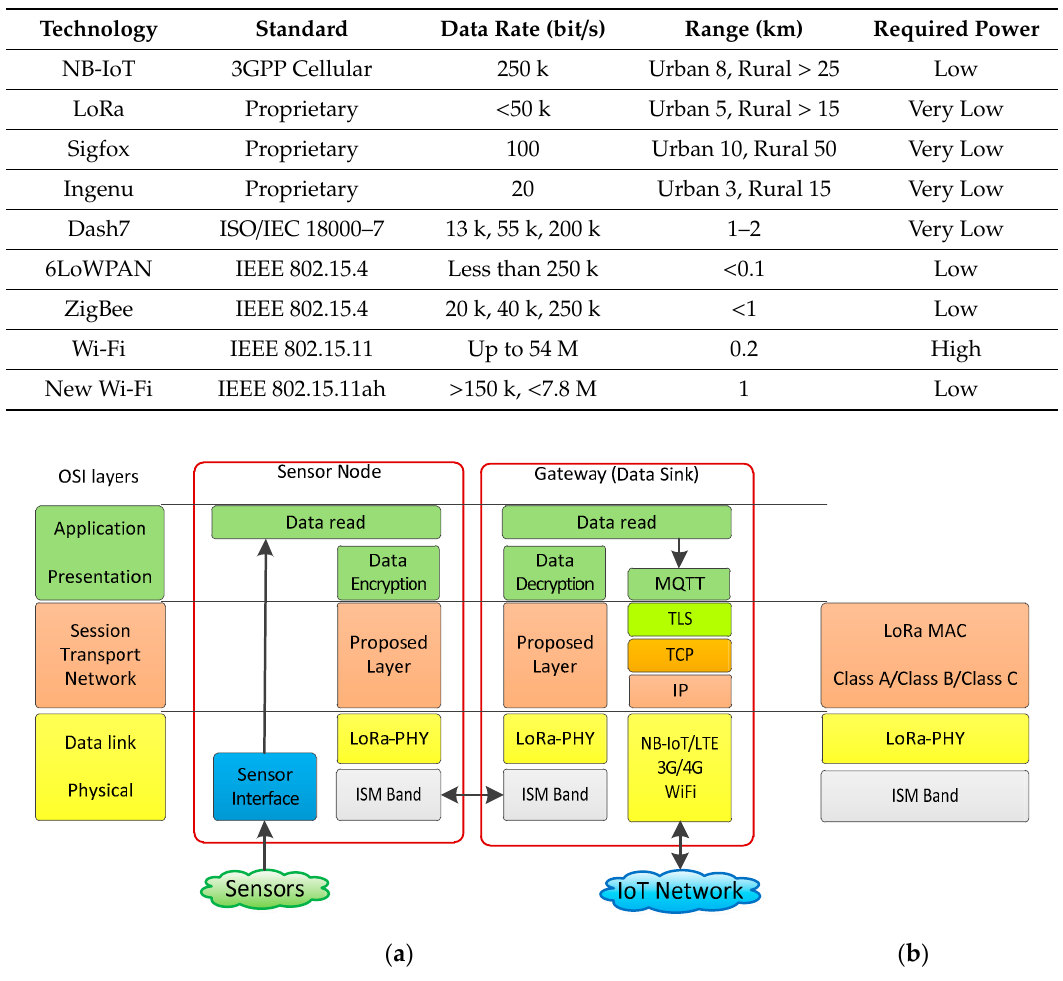
Figure 3. ( a ) LoRa network protocol for the WARM system, ( b ) LoRaWAN protocol